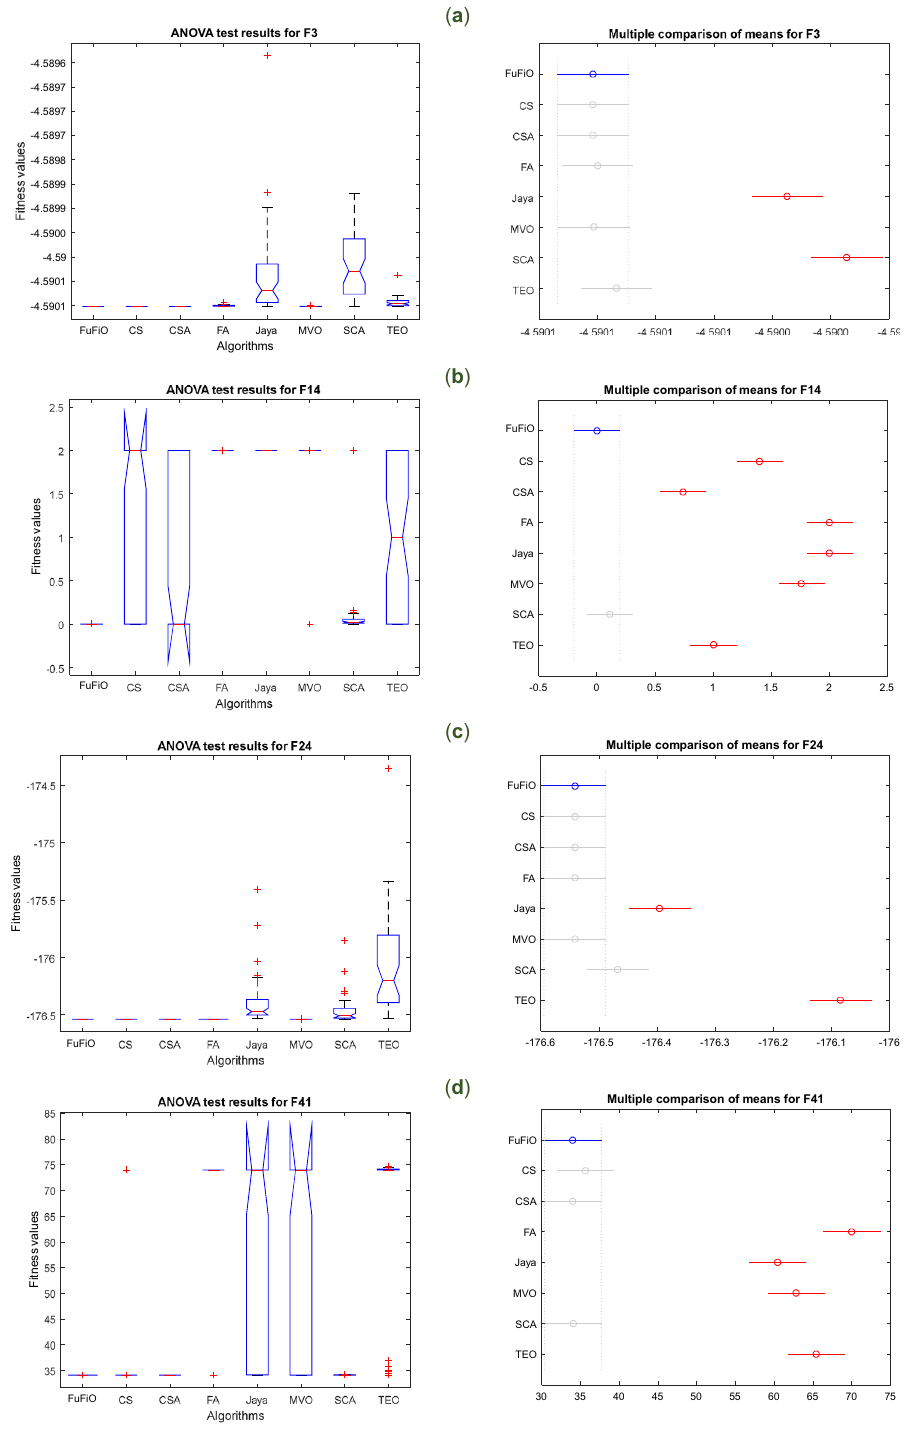
Figure 13. ANOVA test results for fixed-dimension